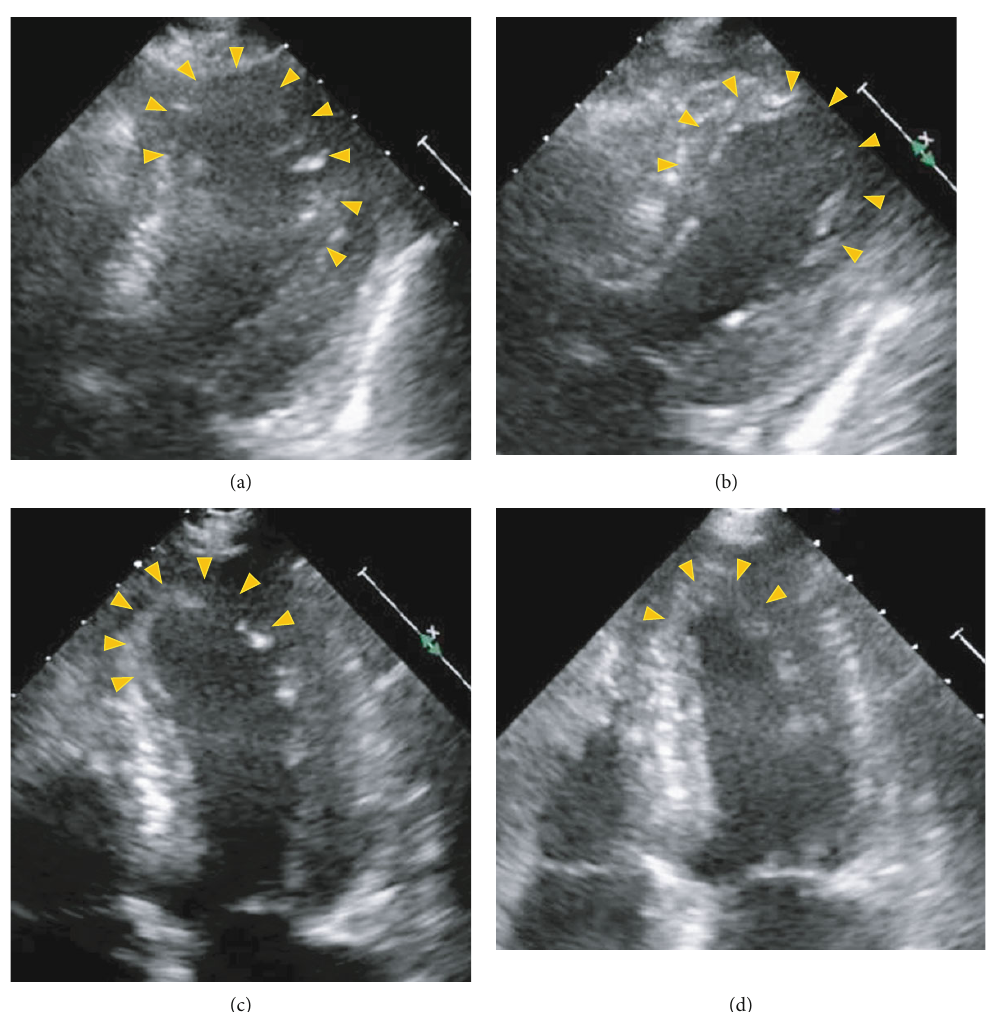
Figure 3: Echocardiogram shows gradual improvement of left ventricular systolic dysfunction: (a) admission (day 0), (b) hospital day 2, (c) day 5, and (d) day 9. Yellow arrow indicates an area of abnormal wall motion in